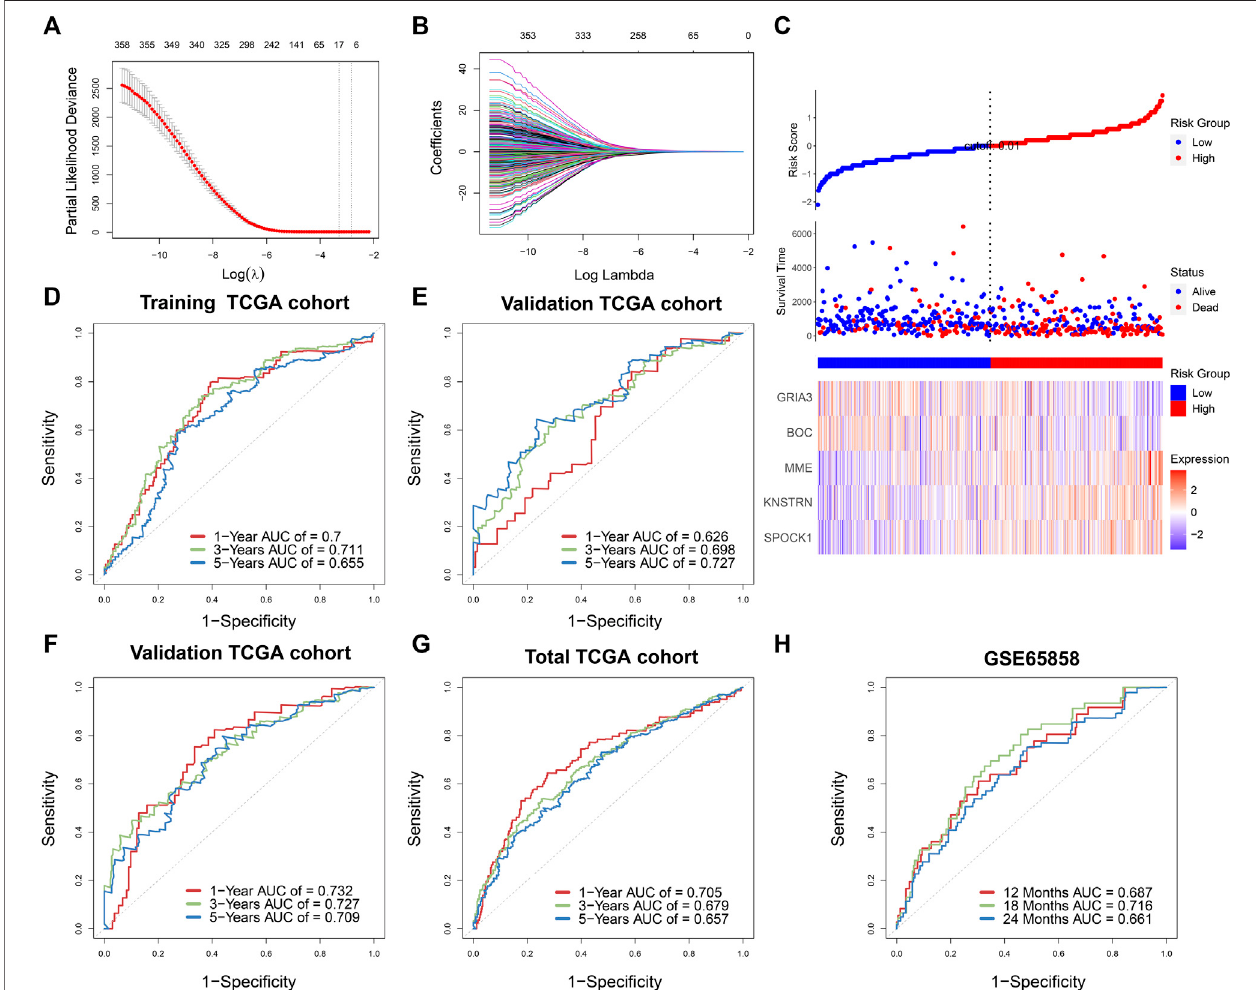
FIGURE 4 | (A) Stemness-related genes were selected by the least absolute shrinkage and selection operator (LASSO) regression model according to minimum criteria. (B) The coef fi cient of stemness-related genes was calculated by LASSO regression. (C) Risk score distribution in 499 TCGA-HNSCC based on the fi ve stemness-related genes. Area under time-dependent receiver operating characteristic curve (AUC) veri fi ed the prognostic accuracy of stemness prognostic index (SPI) inthetraining( n =332) (D) andvalidating( n =167)TCGAcohort (E) .AUCveri fi edtheprognosticaccuracyofmultivariateCoxregressionmoduleincludingSPI,age, gender, Tstage, N stage, and M stage in the validating TCGA cohort ( n =167) (F) , the total TCGA cohort ( n = 499) (G) , and theexternalGSE65858 cohort ( n = 270) (H) .